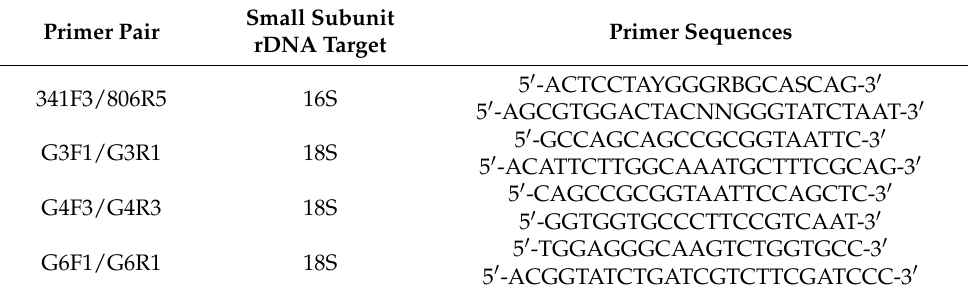
Table 1. Primers used in the metabarcoding